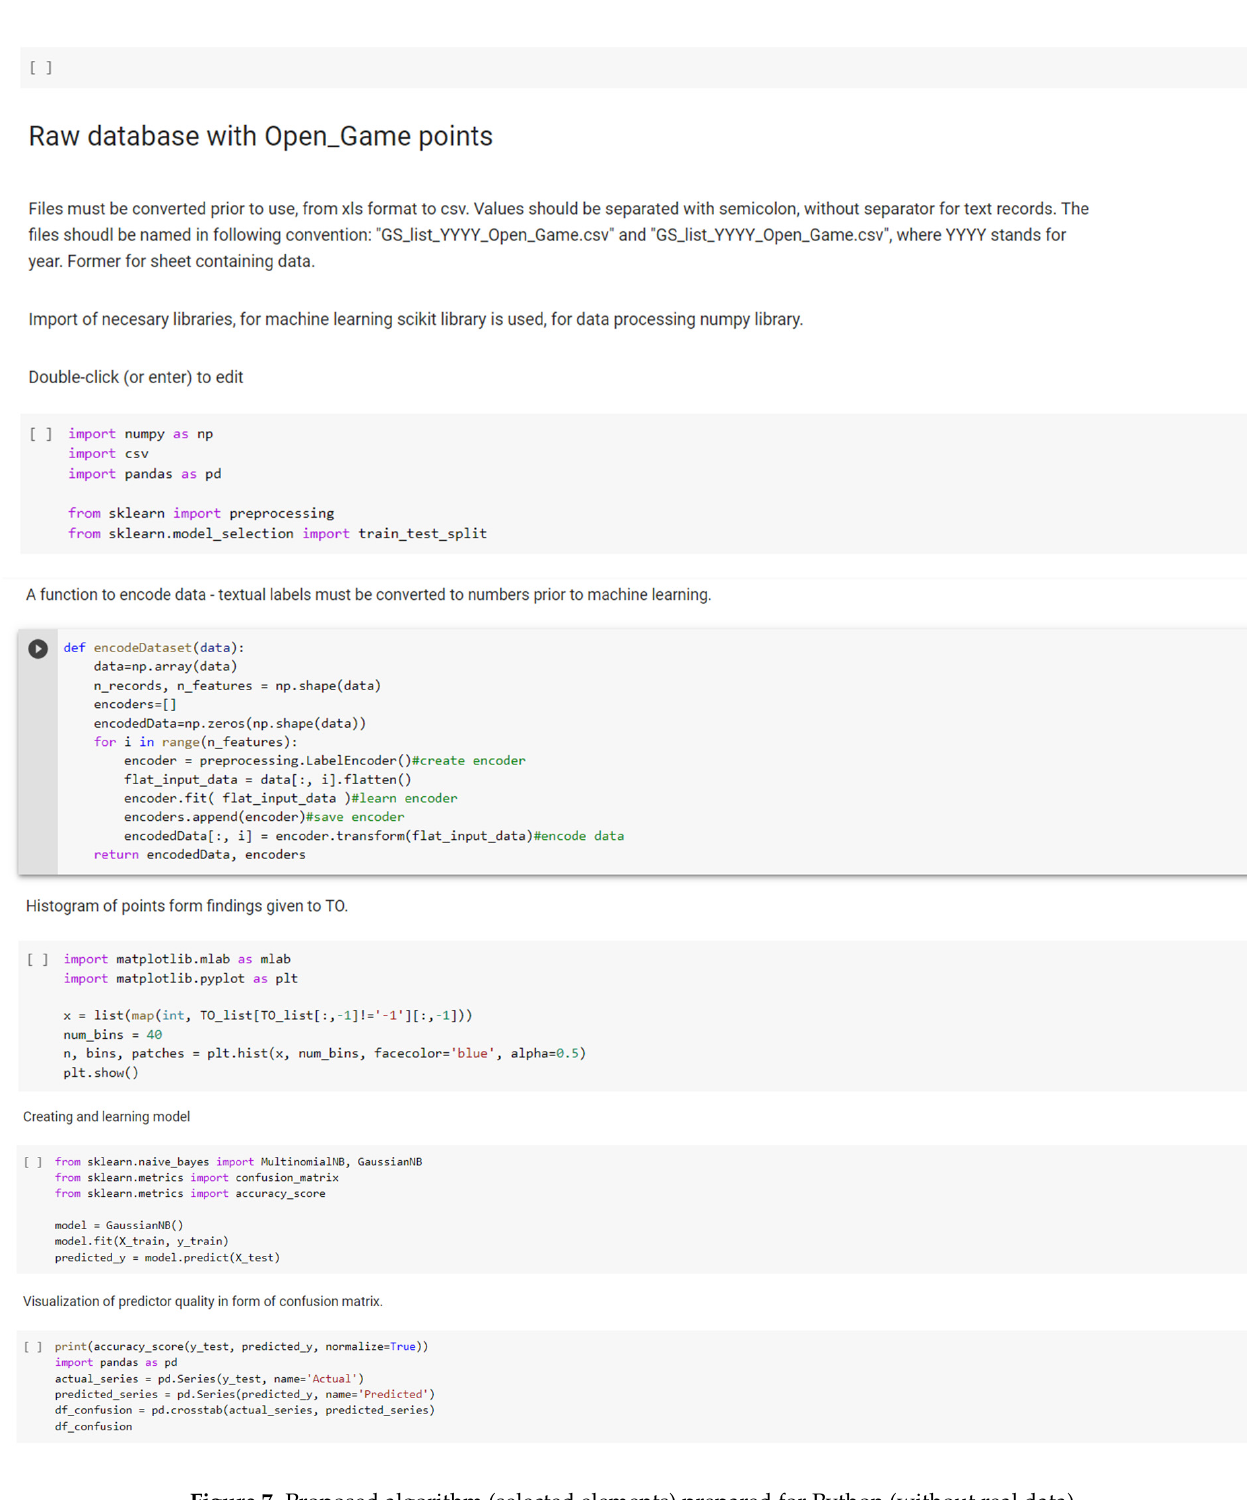
Figure 7. Proposed algorithm (selected elements) prepared for Python (without real data).